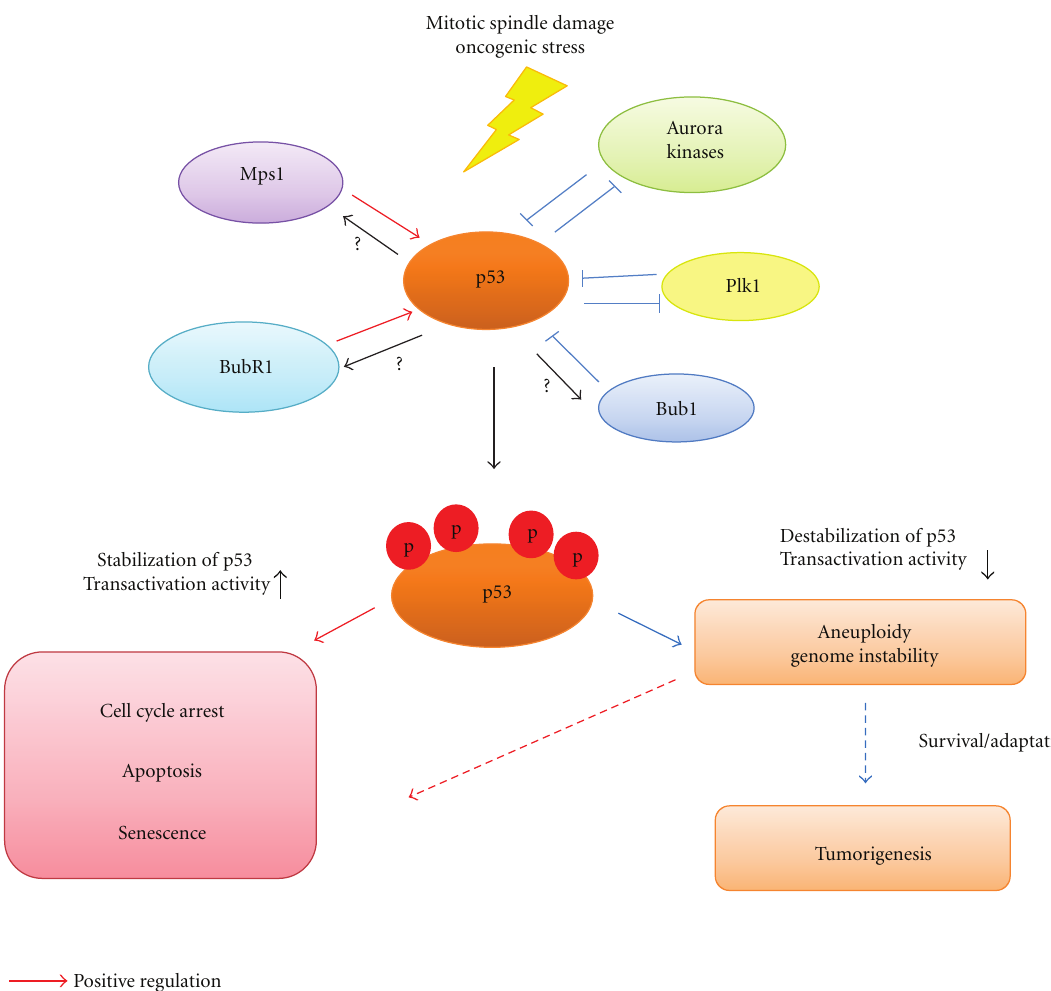
Figure 1: A model for regulatory networks of mitotic kinases controlling p53